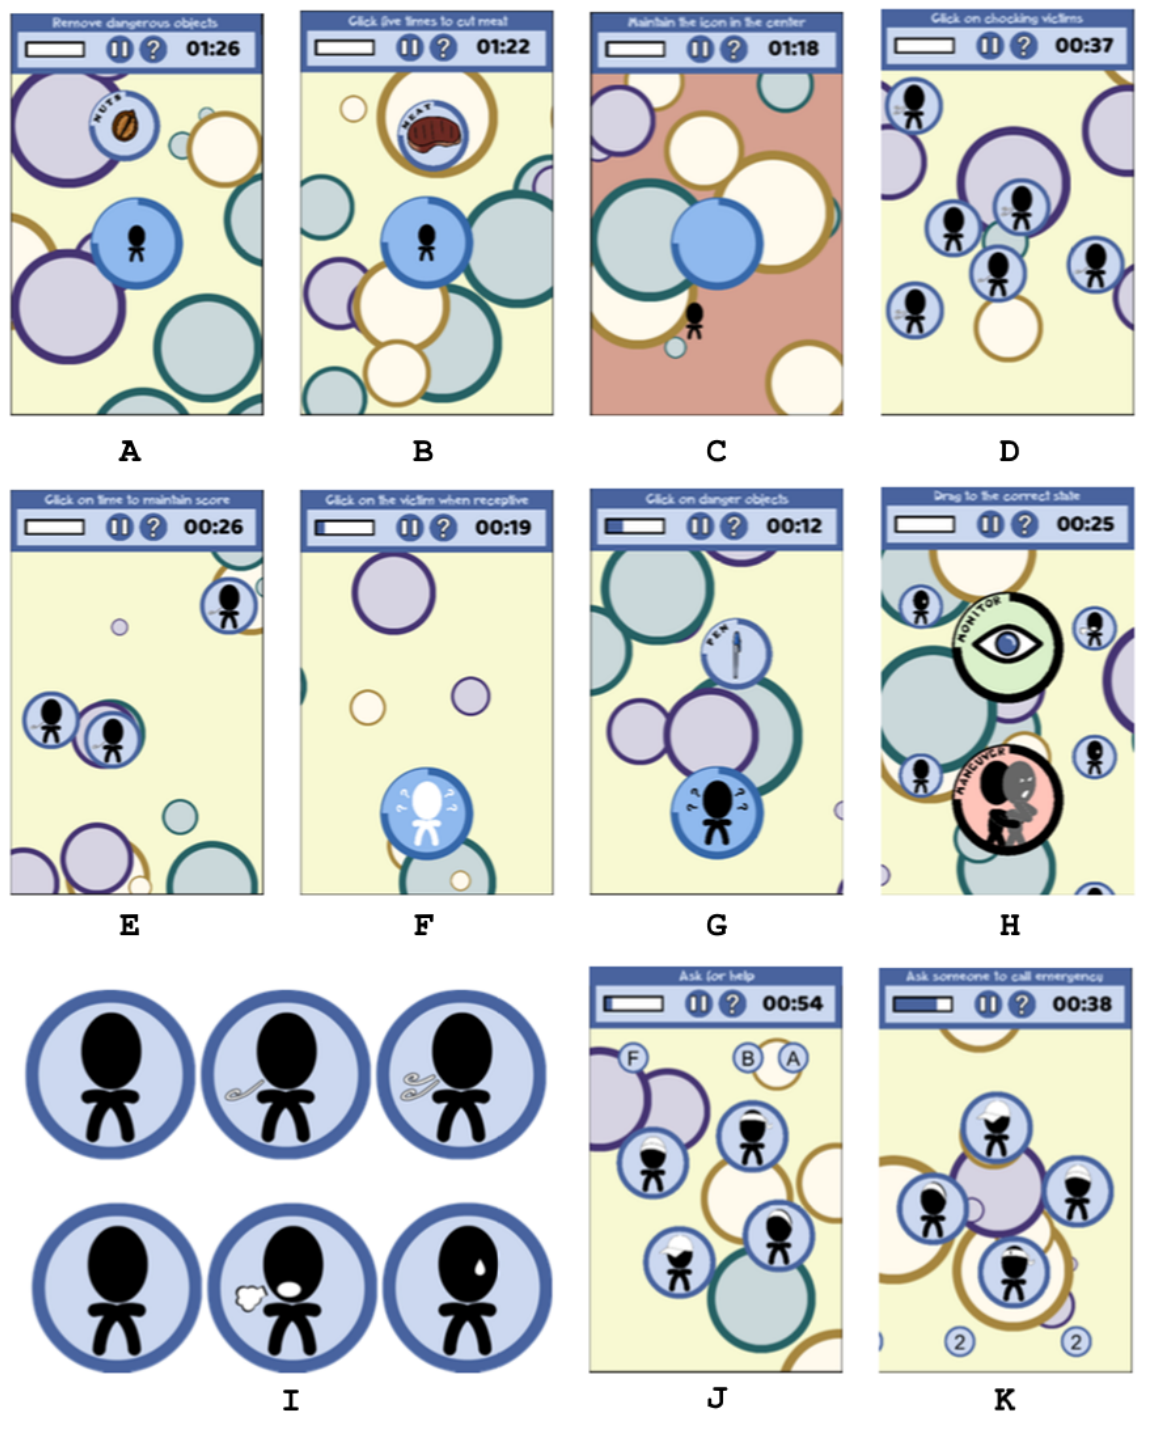
Figure 3. Choking prevention minigame. A. Avoid small and dangerous objects. B. Keep food pieces small. C. Do not move while eating. D and E. Identify choking persons minigame. F and G. Ask for response minigame. H. Identify choking symptoms minigame. I and J. Ask for help